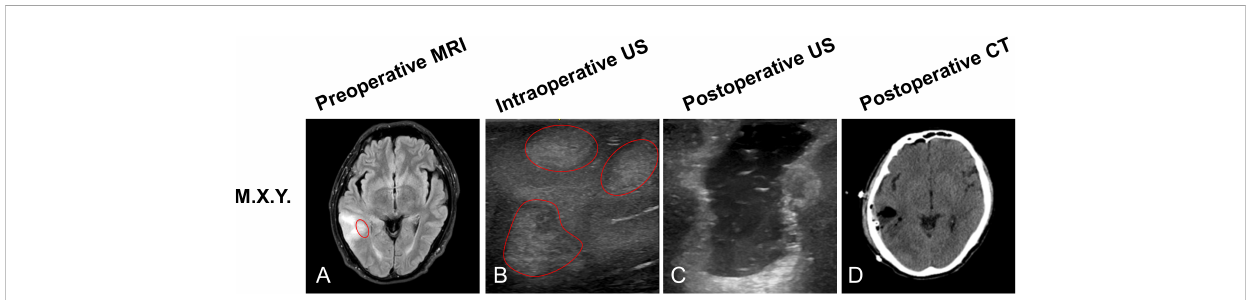
FIGURE 2 Illustrating case 1: M.X.Y, a 57-year-old male patient, MRI sequences showed one tumor located at the right temporal ( A , red circle). Prior to opening the dura, ioUS revealed three tumors (three hyperechoic signals) in the operative fi eld ( B , red circles). The doctor used the ioUS to evaluate the surgical fi eld at the ending of the resection and found no tumor remnants (C) . The postoperative CT scan reveals no signs of the tumor (D) . Histopathology indicated that the patient had recurrent Glioblastoma WHO grade 4.